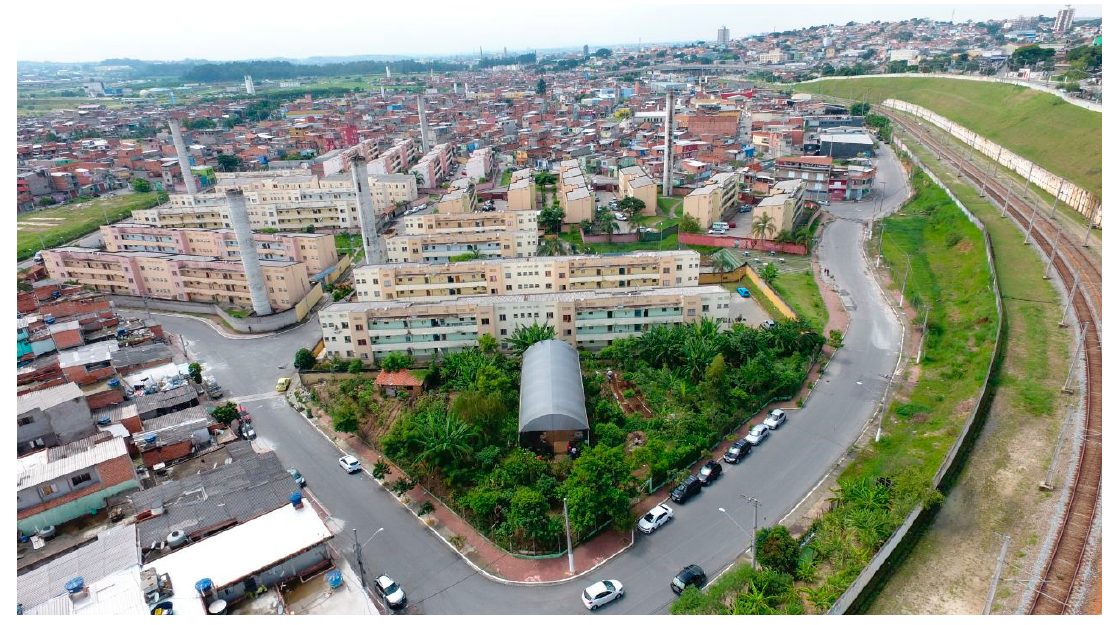
Figure 1. Aerial picture of the community garden Viveiro Escola União de Vila Nova . Source: CDHU , 2018.